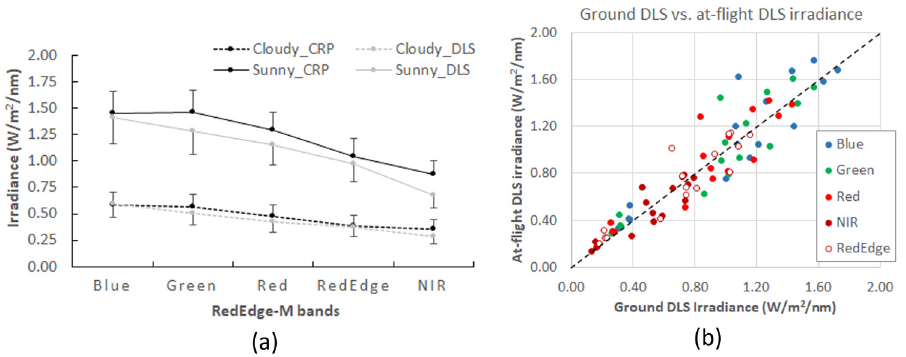
Figure 3. Sampled CRP and DLS irradiance curves on sunny and cloudy days ( a ) and comparison of on-ground vs. at-flight DLS irradiance during flight missions ( b ). The one standard deviation bar is marked above the CRP point and below the DLS point in ( a ).